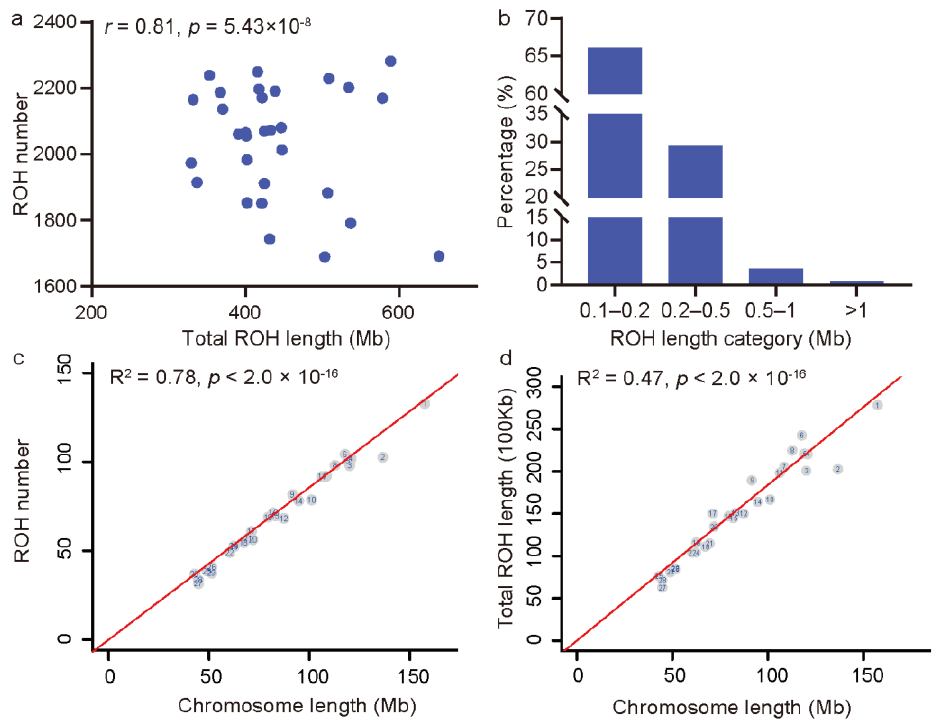
Figure 2. Summary of ROH detected in JC goats. ( a ) The summary of the total ROH number and length in the genome of each JC goat. ( b ) Proportions of the ROHs with different length classes. ( c ) and ( d ) The linear relationship between the number of ROH on each chromosome and the chromosome length. The numbers in the circles are the chromosome numbers. The regression slopes were 0.857 for the ROH number and 1.841 for the total ROH length on each chromosome.